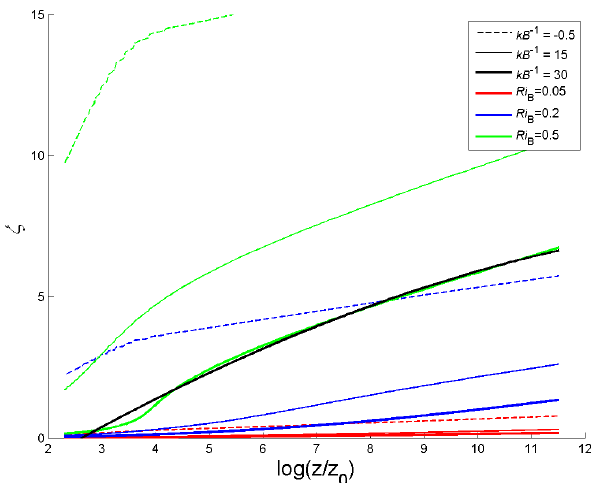
Fig. 3. The relationship between log (z/z 0 h ) (i.e., kB − 1 ) and ζ from the precise results of CB05. Black line indicates the cubic fit of curve z/z 0 = 10 and Ri B = 0 . 5 with least square method.